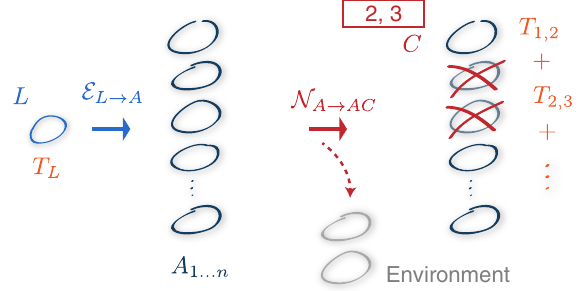
FIG. 4. The general setting of Theorem 2. An approximately charge-conserving encoding maps a logical state onto several physical systems. The noise acts by randomly erasing some subsystems and storing a record of which systems are erased in a register C . Which combinations of subsystems can be lost and with which probability can be chosen arbitrarily. The continuous symmetry is assumed to have a generator represented by T on L the logical system and by T on the physical systems. We assume P A T α , where each that T can be written as a sum of terms T A A ¼ T α acts on a combination of subsystems that could possibly be lost to the environment. For instance, T may include a term A T 3 acting on systems A 3 A 4 A 7 only if the noise model is such ; 4 ; 7 that the systems 3, 4, and 7 have a nonzero probability of being simultaneously erased. The different terms may overlap and do not have to